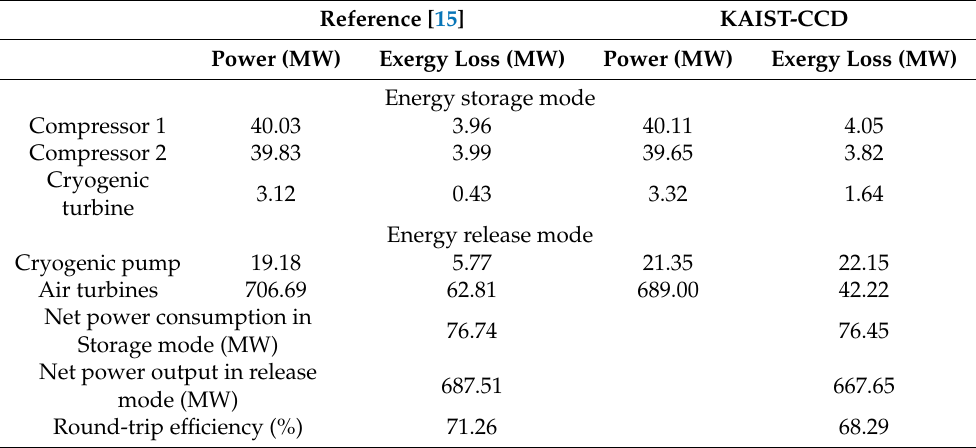
Table 4. Performance summary for reference data from [15] (left) and KAIST-CCD (right).